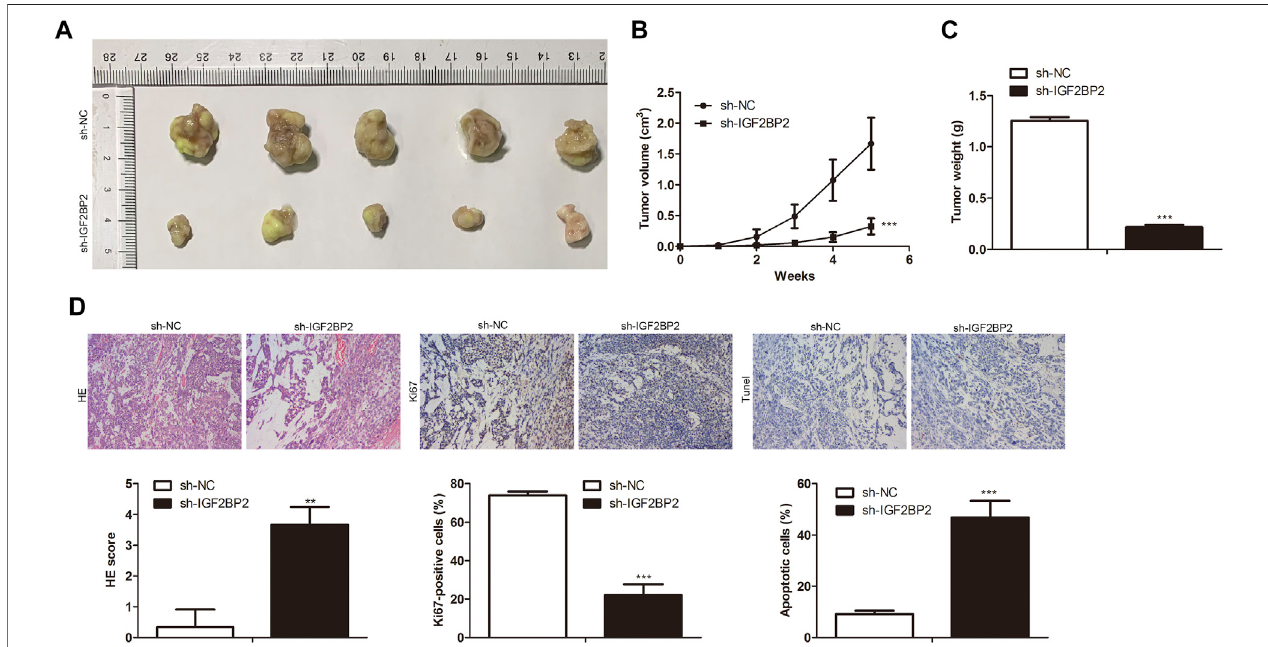
FIGURE 6 | IGF2BP2 knockdown decreases drug resistance of crizotinib-resistant NSCLC in vivo . (A) Tumor size. (B) Statistical analysis of tumor volume. (C) Statisticalanalysisoftumorweight. (D) H&Estaining,IHCstainingofKi67andTunelassayintumortissues.** p < 0.01,*** p < 0.001 vs sh-NCgroup.Errorbarsrepresent SD. Data represent three independent experiments.